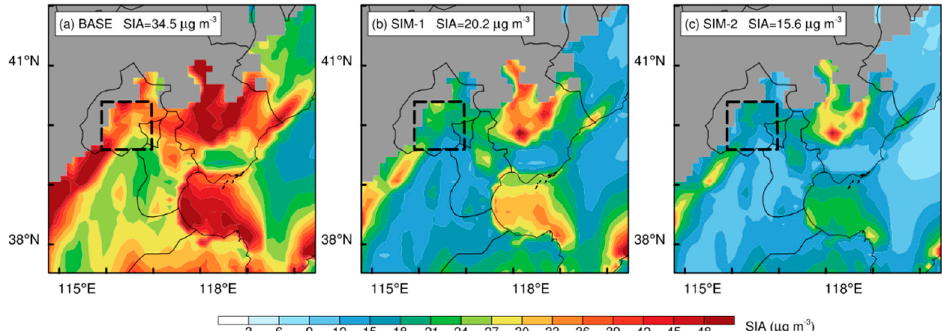
Figure 9. Spatial distributions of near-surface secondary inorganic aerosols (SIA) concentrations in the